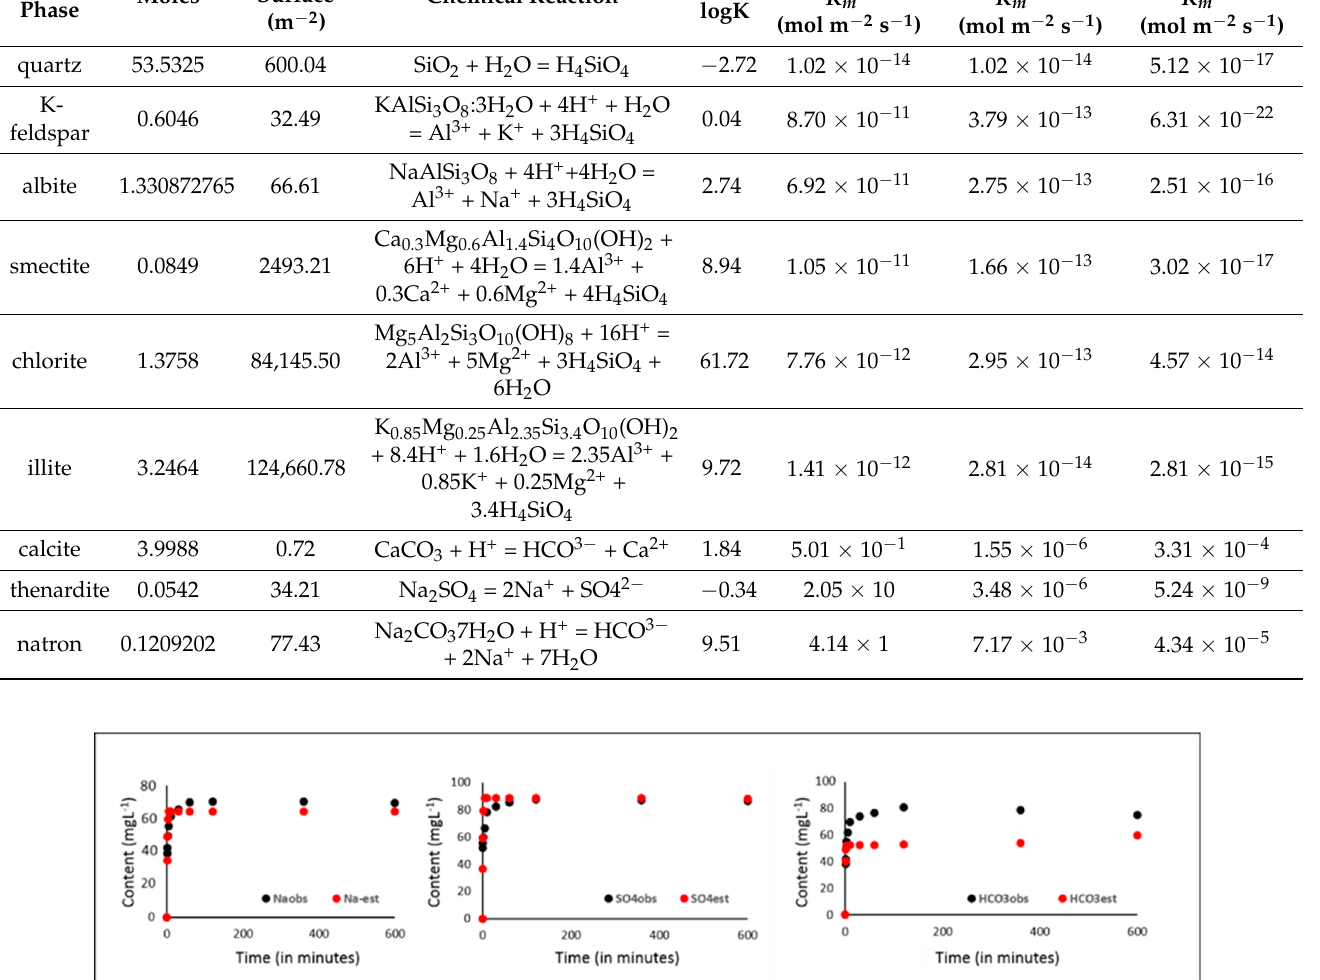
Figure 6. Chemical composition (Na + , SO 42 − and HCO 3 − ) of leached water (observed water: black dots) compared with the results of the bets calibration of the kinetic model (estimated water: red